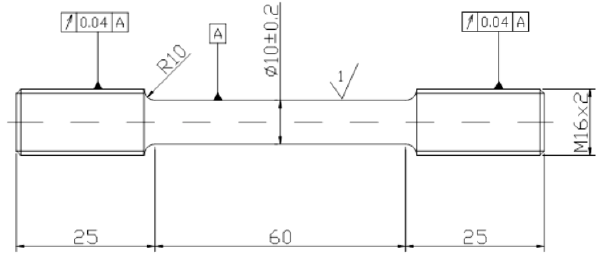
Figure 2. Tensile specimen geometry employed for the testing (dimensions in mm).